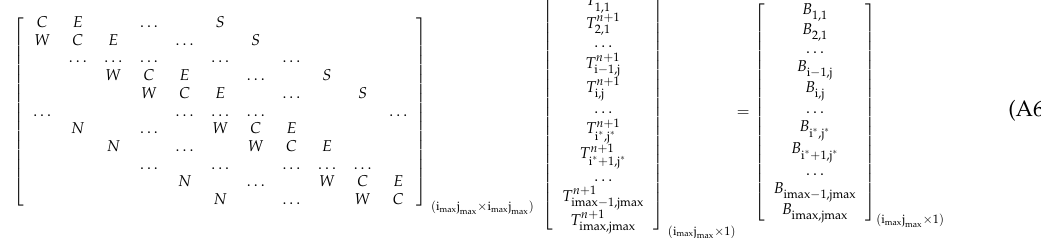
Figure A4. Flowchart of calculation procedure.